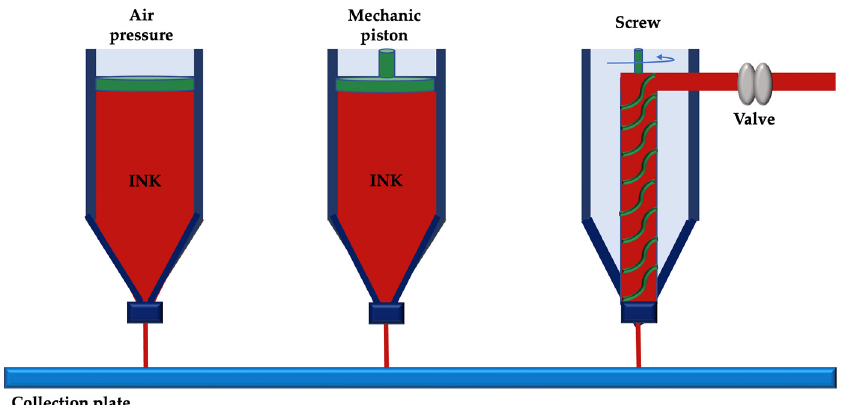
Figure 8. Non-thermal extrusion 3D printing.